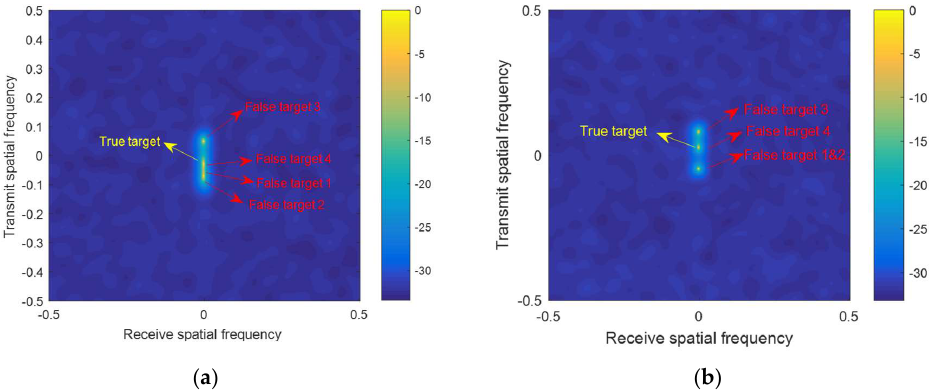
Figure 5. Capon spectrum distributions in the transmit-receive frequency domain. ( a ) Before range compensation. ( b ) After range compensation.